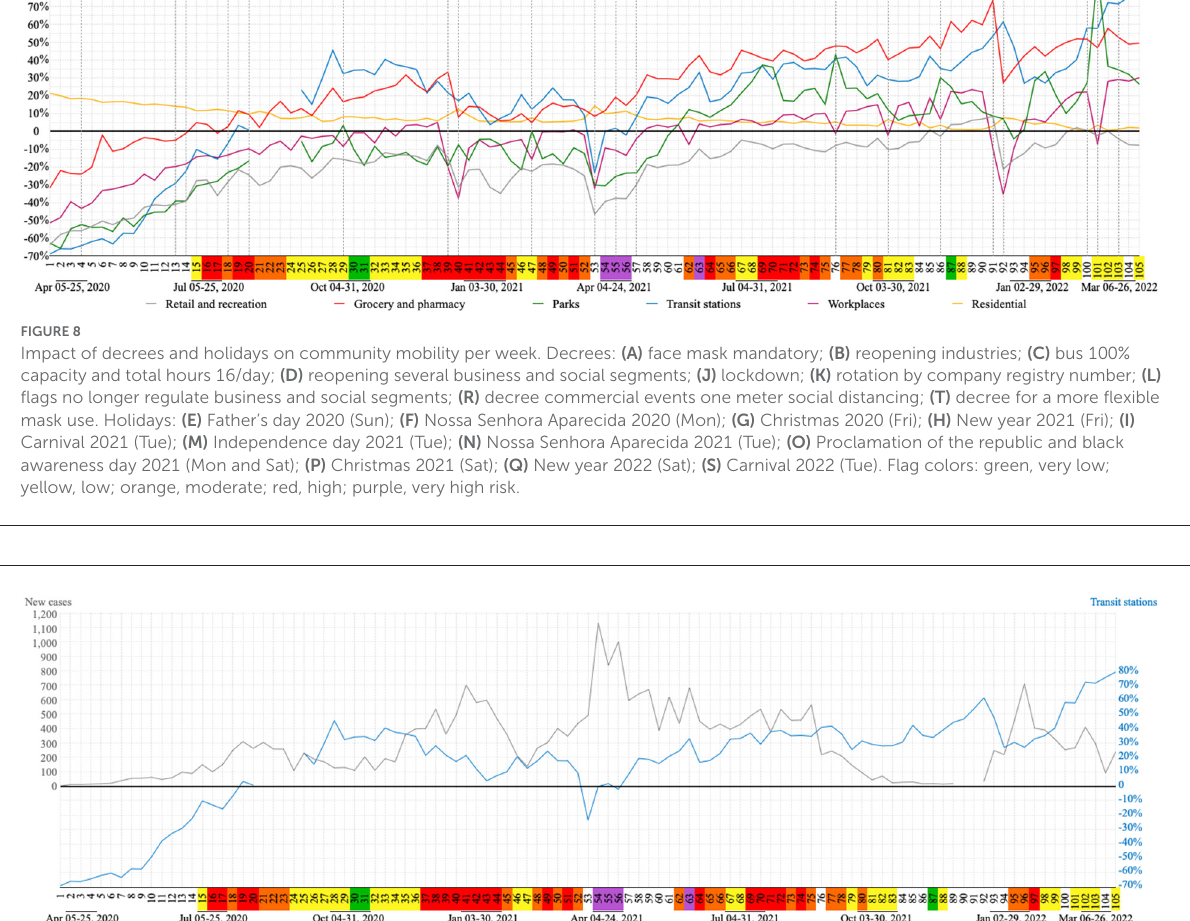
Retail and recreation, grocery and pharmacy, parks,